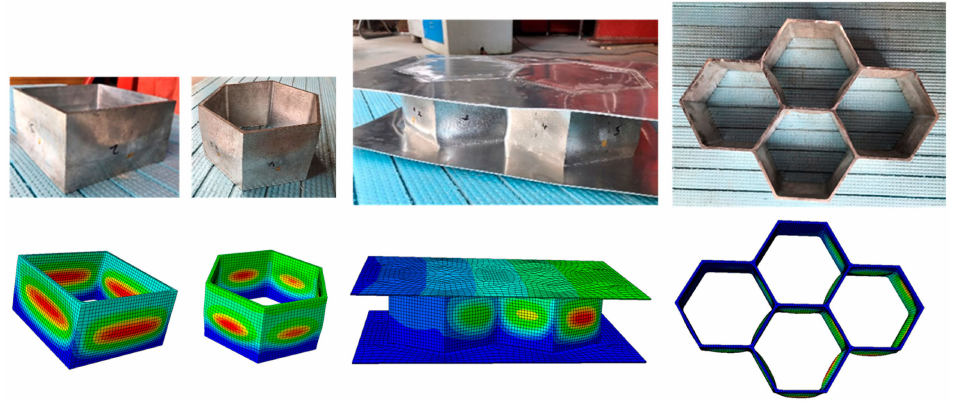
Figure 12. Comparisons between numerical and experimental failure modes of honeycomb specimens.